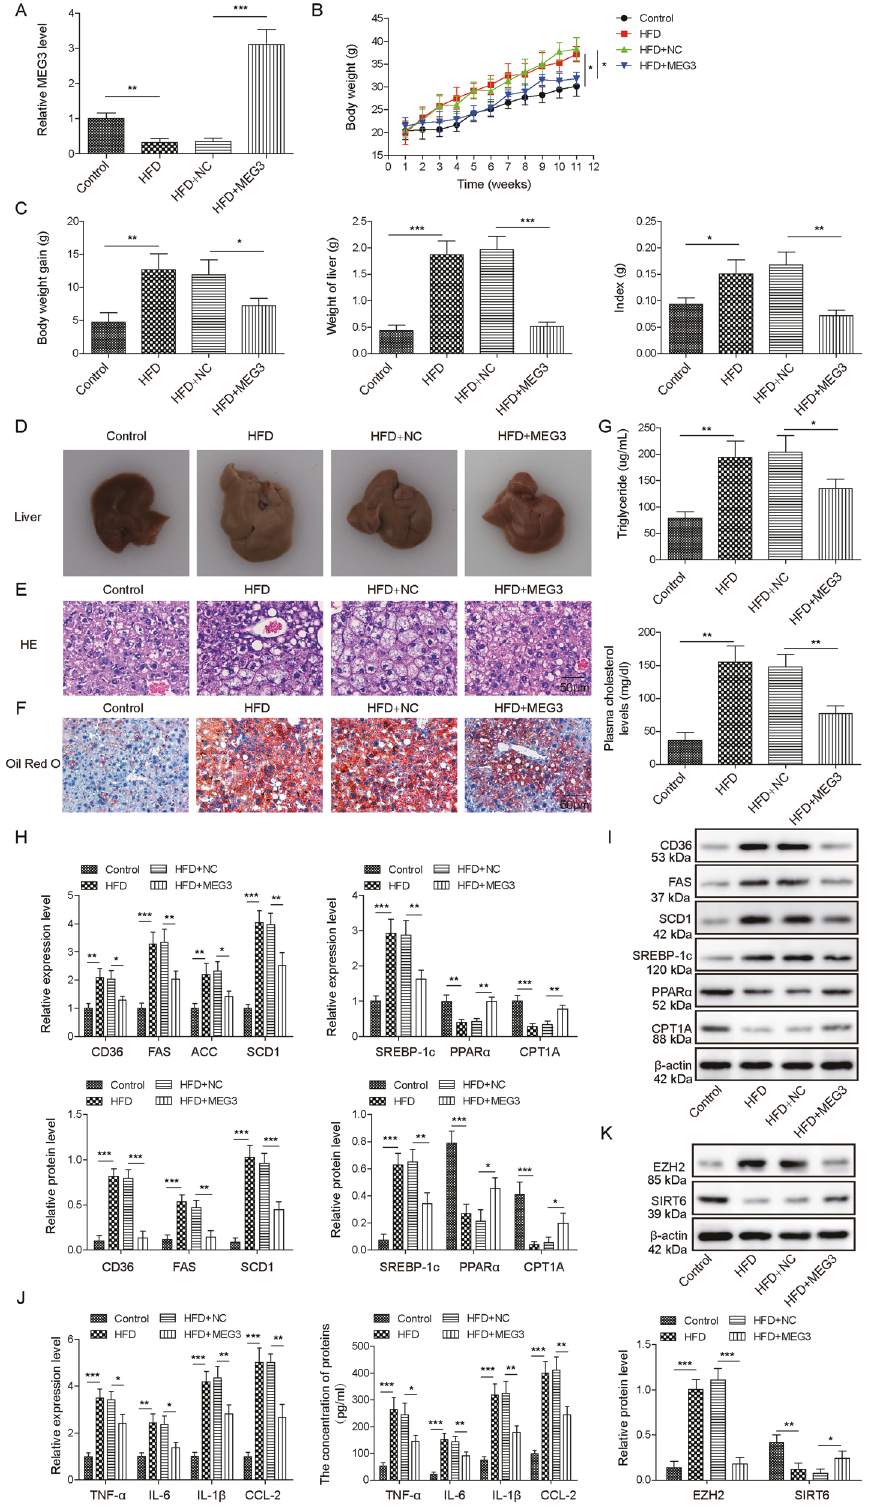
Fig. 5 Overexpressing MEG3 alleviated NAFLD in vivo. Empty AAV(NC) or MEG3-expressing AAV was injected into tail vein of mice before these mice were fed with high-fat diet (HFD) for 12 weeks. Mice not injected with AAV (control) were used as the negative control. A MEG3 expression in liver tissue was examined by RT-qPCR. B The body weight curve for each group. C At the time of sacri fi ce, the body weight, the liver weight, and the liver/body weight index were examined for each group. Representative images of the whole liver ( D ), HE staining ( E ), and Oil Red O staining ( F ) of liver tissues from each group were shown. G Serum triglyceride and total cholesterol levels were measured from each group. The mRNA ( H ) and protein ( I ) levels of indicated lipogenesis-related genes, expressions and productions of pro-in fl ammatory cytokines ( J ), and protein levels of EZH2 and SIRT6 ( K ) were examined in liver tissues from indicated group of mice. * P < 0.05, ** P < 0.01, *** P < 0.001.